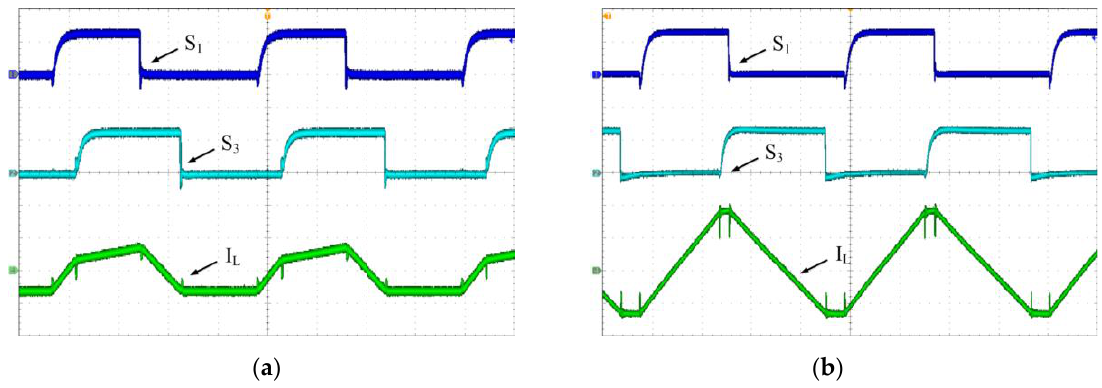
Figure 17. Measured waveforms using different control methods (50 W). ( a ) Proposed APS control method (41°); ( b ) Fixed phase-shift value (148°). (CH1: 10 V/div, CH2: 10 V/div, CH4: 1 A/div, Time: 8 μs/div).